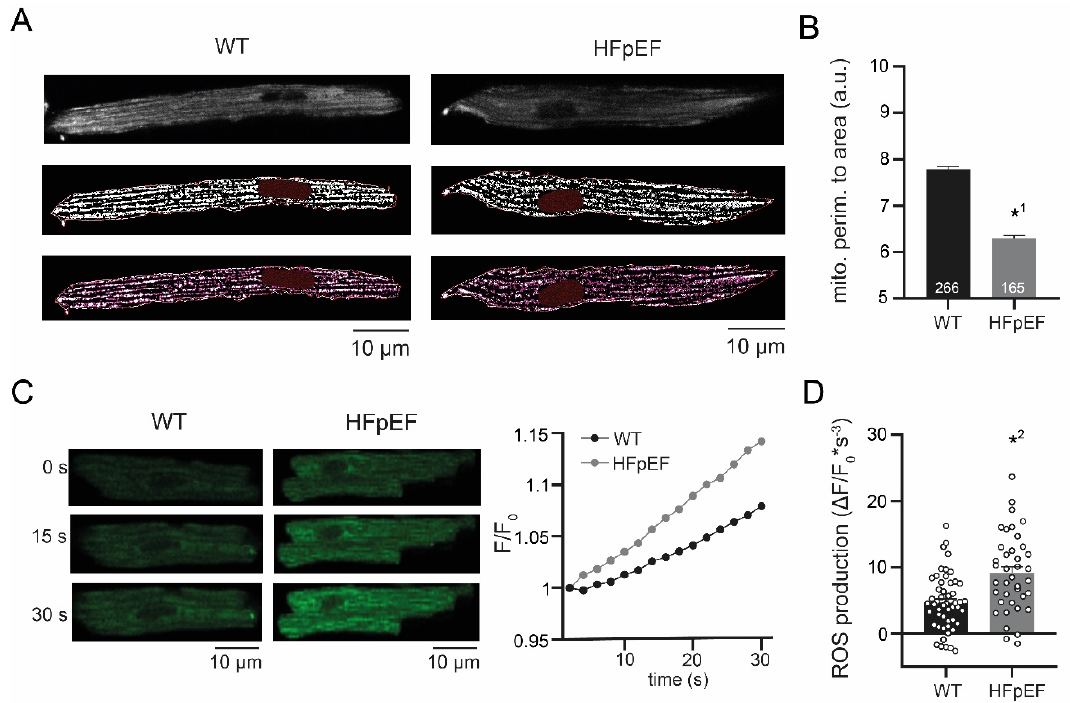
Figure 2. ( A ) Representative example of mitochondrial structure (dye: Mitotracker) in left atrial cardiomyocytes (upper), after thresholding (center) and after contour analysis (lower). ( B ) Corresponding data of structural perimeter to area ratio as an indicator mitochondrial fission. ( C ) Representative example of ROS measurements (left; dye: H2DCF) and averaged trace (all cells per group). ( D ) Corresponding data of ROS production. Statistical analysis: Student’s t -test. p -values: * 1 < 0.0001, * 2 < 0.0001. n -numbers indicate cells (from four animals per group).